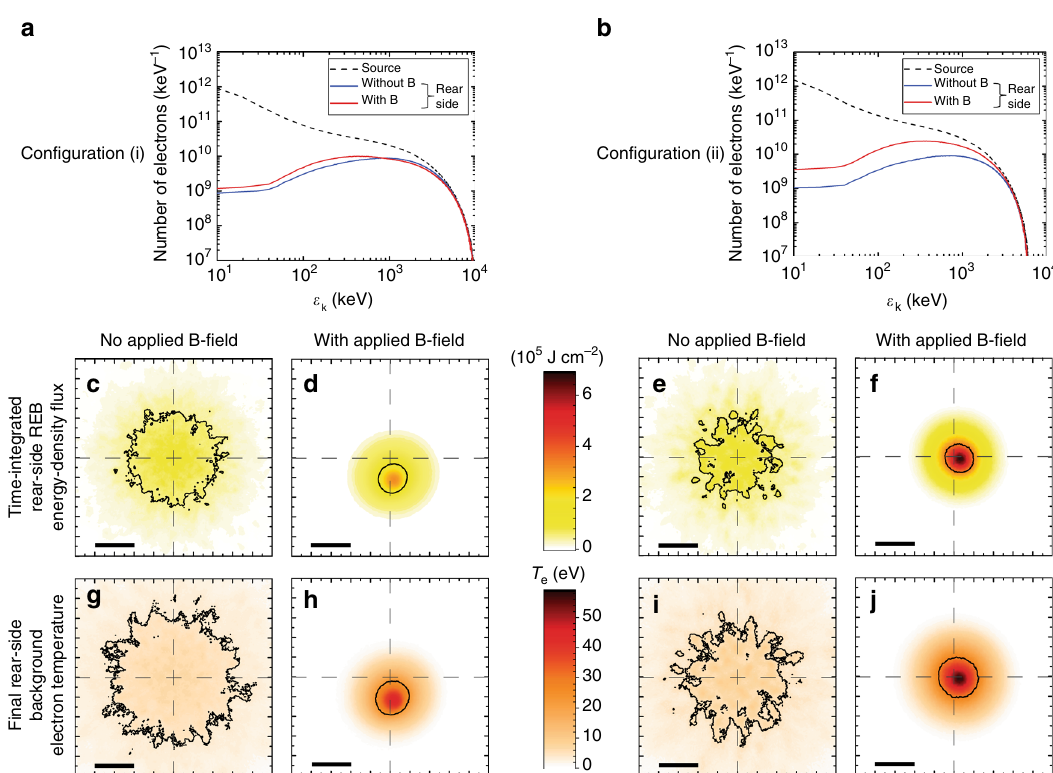
Fig. 3 Relativistic electron beam features unfolded from transport simulations. The results, taken at the end of the 3D PIC-hybrid benchmarked simulation runs, are plotted for target-position con fi gurations (i) on the left and (ii) on the right, without and with B- fi eld. a , b Time-integrated relativistic electron beam (REB) energy spectra at the targets ’ front side (source, dashed lines) and rear side (full lines, red with imposed B- fi eld, blue without B- fi eld). c – f Time-integrated REB energy-density fl ux at the targets ’ rear surface. g – j Final background electron temperature at the targets ’ rear surface. In c – j the black bars stand for the 40 μ m spatial scale, the contour lines correspond to the half-height of the signals and the crossed dashed lines indicate the position of REB injection at the targets ’ front